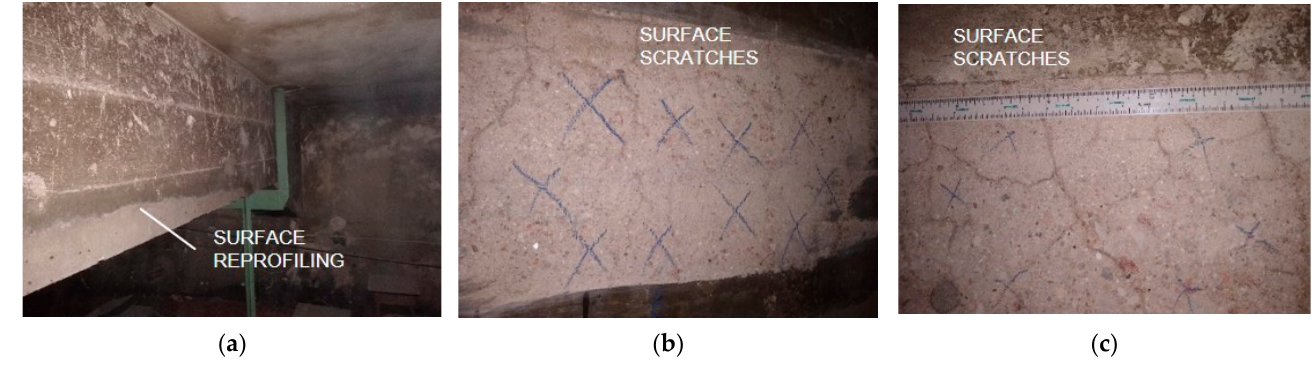
Figure 5. Visual tests: ( a ) view of reprofiled surfaces; ( b , c ) surface cracks.